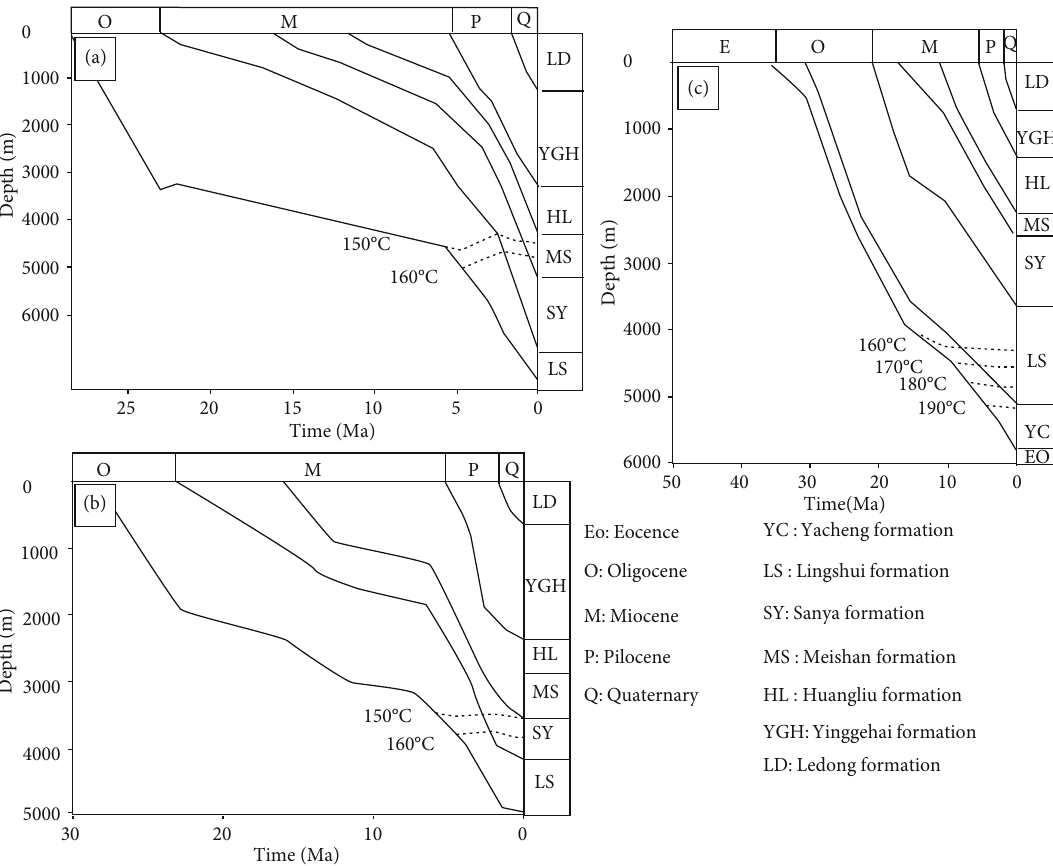
Figure 6: Burial history of (a) the LD10 reservoir, (b) the HK29 reservoir, and (c) the BD19 reservoir in the Ying-Qiong Basin.